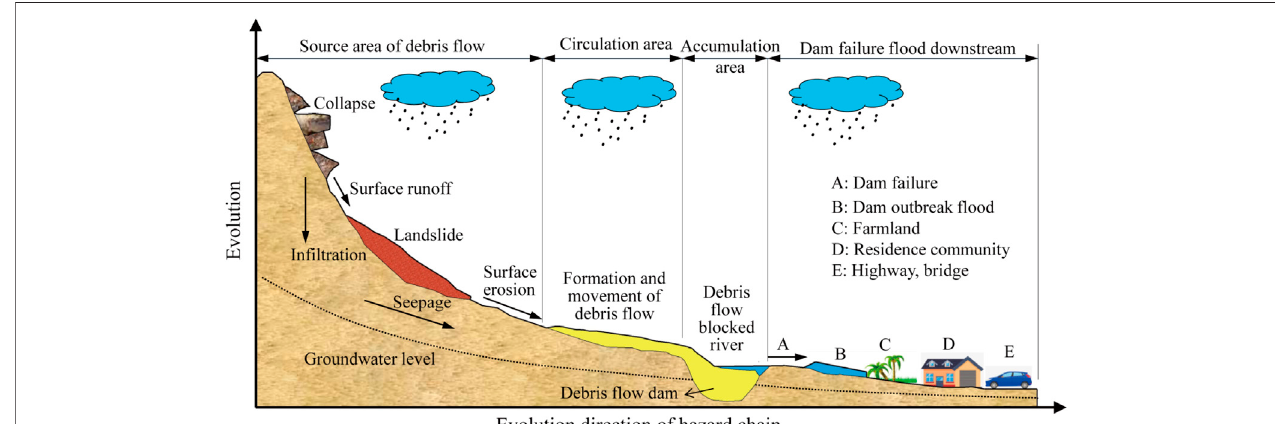
FIGURE 1 | Diagram of the hazard chain